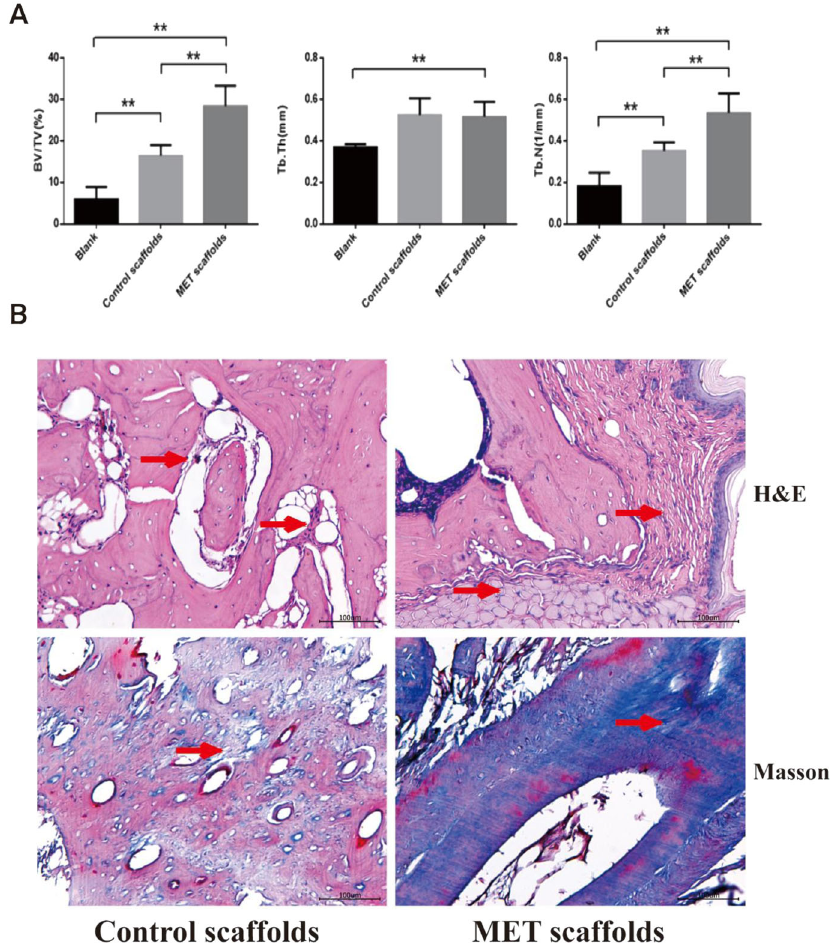
Fig. 7 A Measurements of BV/ TV, Tb.Th, and Tb.N of the alveolar bone. BV/TV trabecular bone volume fraction, Tb.N trabecular number, Tb.Th trabecular thickness. B Images of H&E staining, Masson staining of the alveolar bone. The red arrow indicated new bone formation. Symbol “ ** ” shows the signi fi cant difference between groups ( P <